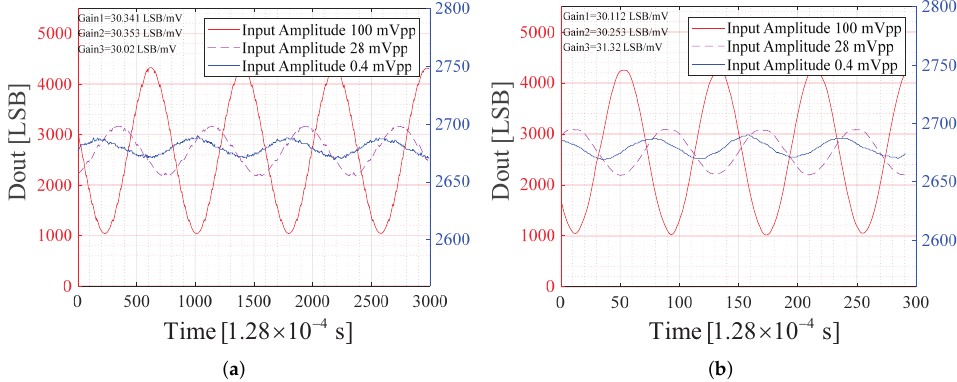
Figure 12. ( a ) Measured waveform of the readout circuit with the input frequency f = 10 Hz. ( b ) Measured waveform of the readout circuit with the input frequency f = 100 Hz.